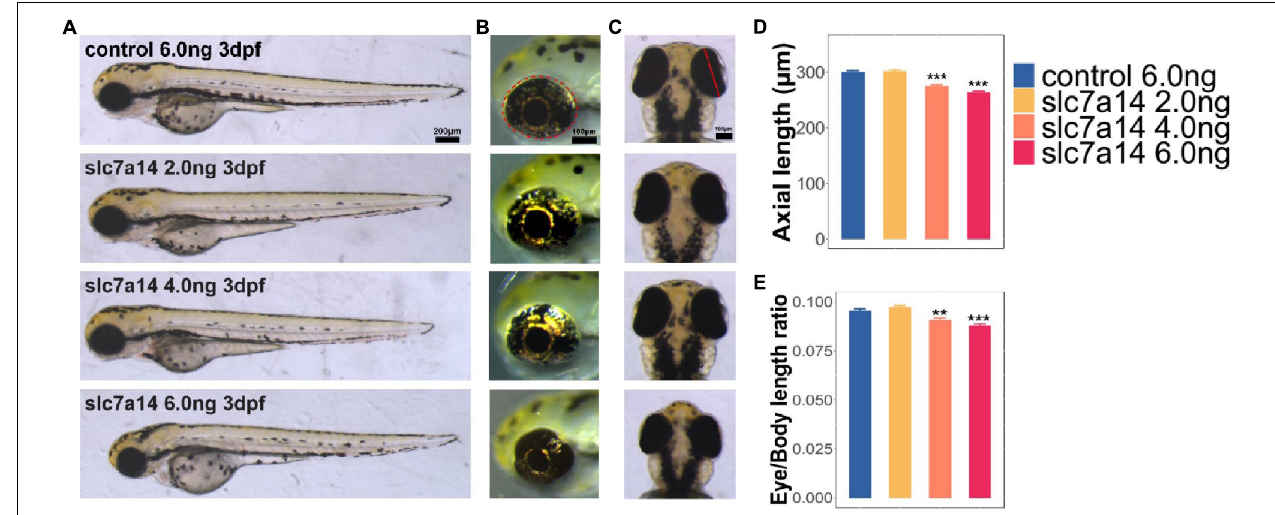
FIGURE 2 | Morphology of slc7a14 -deficient zebrafish morphants. (A) Lateral view of zebrafish larvae. Embryos injected with doses of 4.0 and 6.0 ng MOs exhibited apparent microphthalmia. Scale bar = 200 µ m. (B) Magnified view of larval eyeballs showing the significant reductions in eye area with high-dose MOs. Scale bar = 100 µ m. (C) Vertical view of larval eyeballs showing the reductions in eye axis length with high-dose MOs. Scale bar = 100 µ m. (D,E) Quantification of eye axis length and the axis-to-body length ratio. N = 46 in each group. Bar plots are shown as the mean ± s.e.m. Data was analyzed using One-way ANOVA followed by Tukey’s post hoc test, ∗∗ P < 0.01, ∗∗∗ P < 0.001 significantly different from control 6.0 ng